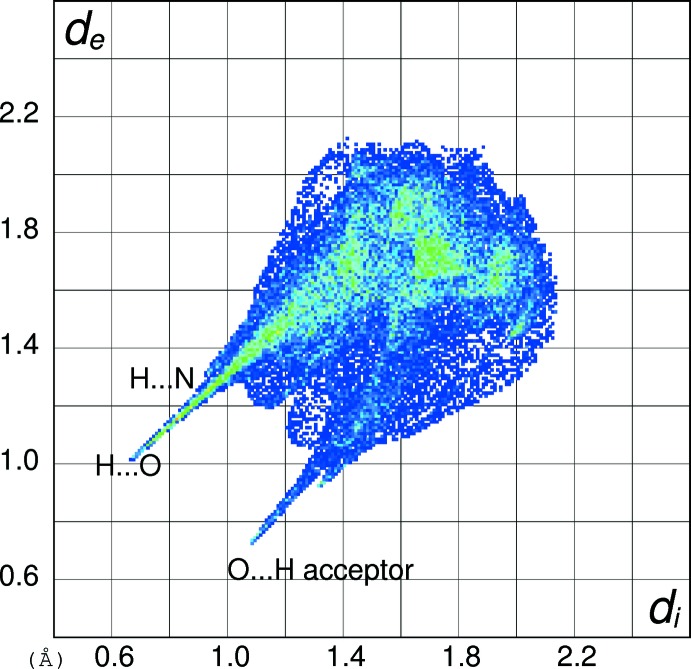
Hirshfeld fingerprint plot for the C7H9N2O2
+ cation in (III).